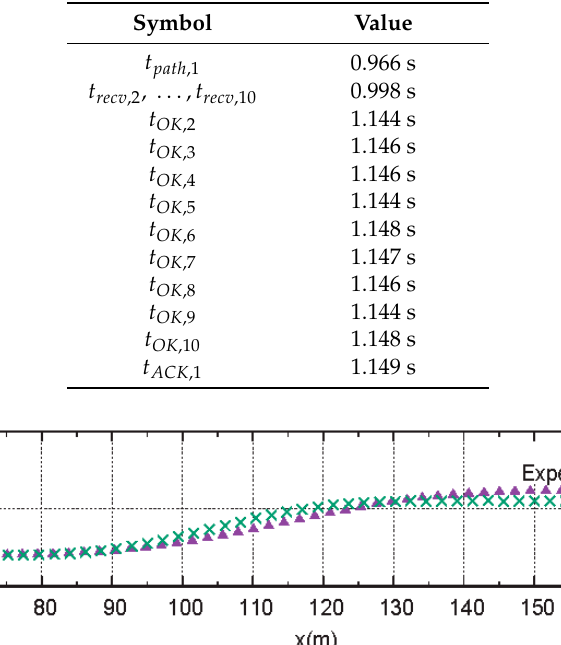
Figure 7. Real positions and expected positions of the host CAV in the lane change.